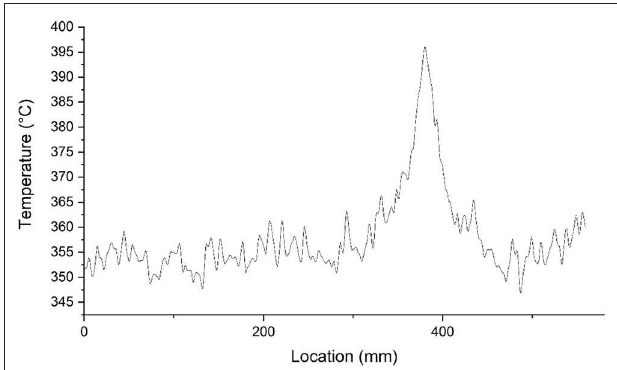
FIGURE 5 | Temperature distribution of beam model I for